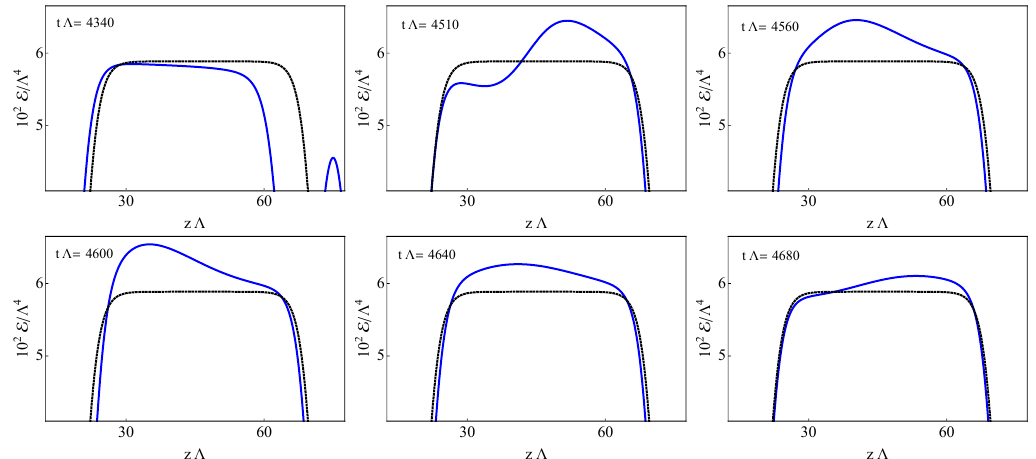
Figure 14 . The continuous blue curves are snapshots of the energy density for the last merger between a peak and a domain in (cid:12)gure 4(left). The dashed black curve shows the pro(cid:12)le at asymp- totically late times. In the (cid:12)rst plot the peak is moving leftward and is about to collide with the domain. In the second and third plots the peak has merged with the domain, creating a perturba- tion that is moving leftward. After bouncing o(cid:11) the interface on the left side, the perturbation is moving rightward in the bottom three plots. The widening and the attenuation of the perturbation as it travels on top of the domain are clearly seen.